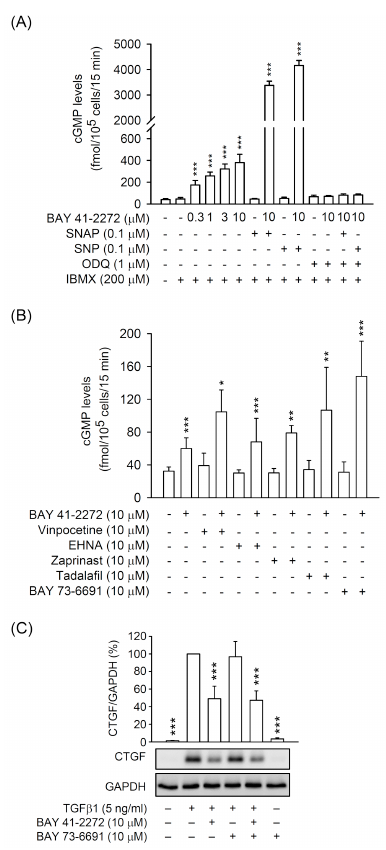
Figure 5. Phosphodiesterase (PDE) inhibitors increase the BAY 41-2272-mediated cGMP formation but not CTGF expression in HSCs. ( A , B ) HSCs were preincubated with or without ( A ) IBMX (200 µ M) and / or ODQ (1 µ M) or ( B ) specific PDE inhibitors for 15 min and then treated with BAY 41-2272 (0.3–10 µ M) in the presence or absence of SNAP (0.1 µ M) or SNP (0.1 µ M) for another 15 min. The cGMP levels were assayed using EIA kits. ( C ) HSCs were pretreated with or without BAY 73-6691 (10 µ M) PDE9 inhibitor for 15 min. HSCs were sequentially incubated with BAY 41-2272 (10 µ M) for 30 min before activation by TGF β 1 (5 ng / mL) for another 6 h. Expressed CTGF and GAPDH were measured by Western blot using the corresponding antibodies. All data are expressed as mean ± SD ( n = 4). * p < 0.05, ** p < 0.01, *** p < 0.001 compared with the basal ( A , B ) or TGF β 1 alone ( C ).